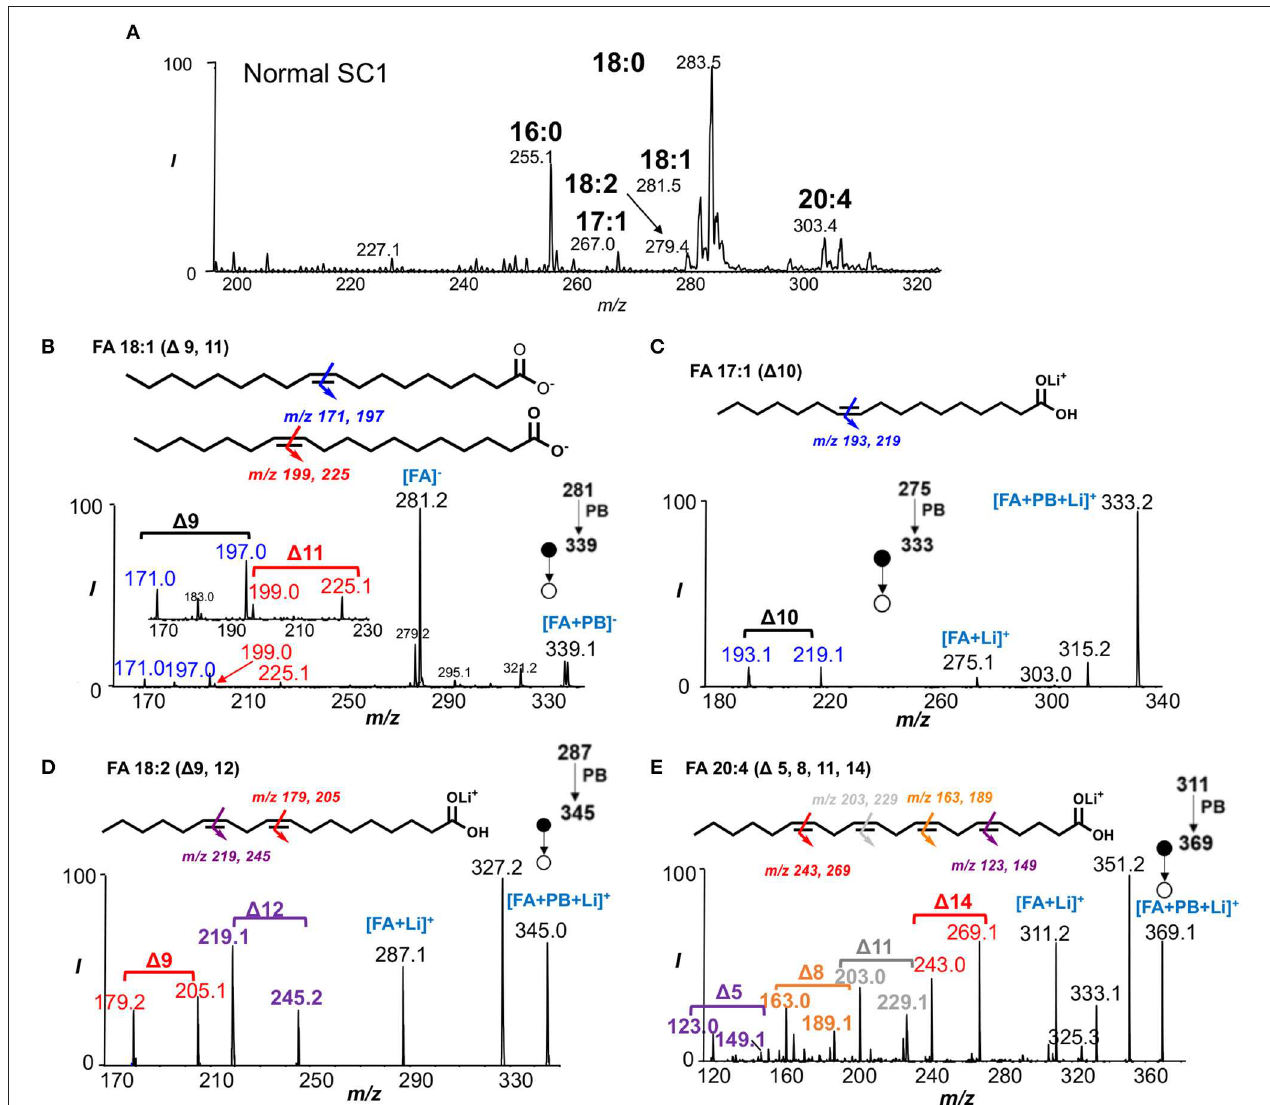
FIGURE 1 | Characterization of fatty acids from crude lipid extract. (A) Rapid profiling of fatty acids in SC1 segment of normal mouse spinal cord. (B) PB-MS/MS of FA 18:1 shows two C = C location isomers ( 1 9 and 1 11). (C) Structural identification of FA 17:1 using PB-MS/MS reveals the presence of C = C at 1 10. (D) PB-MS/MS of FA 18:2 unravels 1 9 and 1 12 C = C positions. (E) PB-MS/MS of FA 20:4 reveals the locations of four double bonds at 1 5, 1 8, 1 11, 1